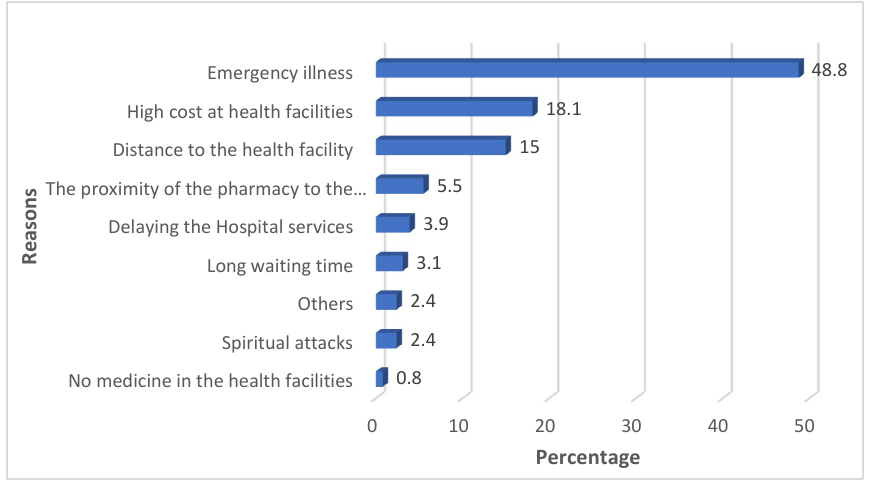
Figure 2. Reasons for self-medication during pregnancy.